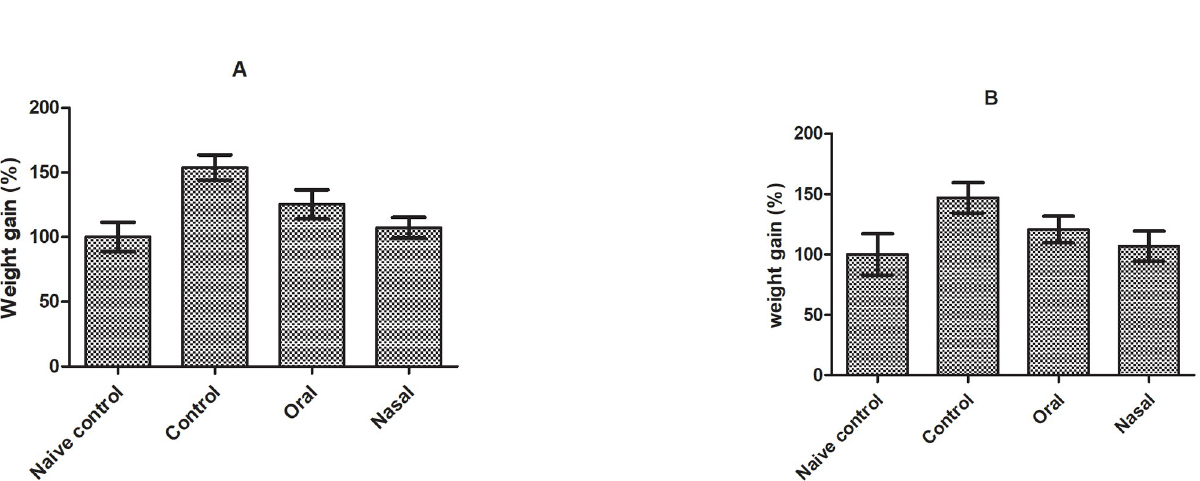
Fig 5. Effect of different treatments on weight of (A) lung and (B) liver in OVA induced asthma model.